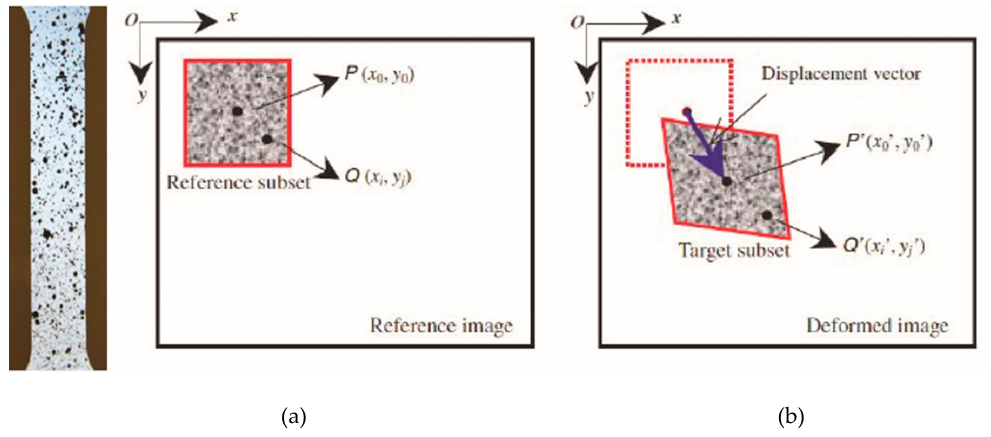
Figure 2. Digital image correlation (DIC); ( a ) surface pattern; ( b ) cross correlation.